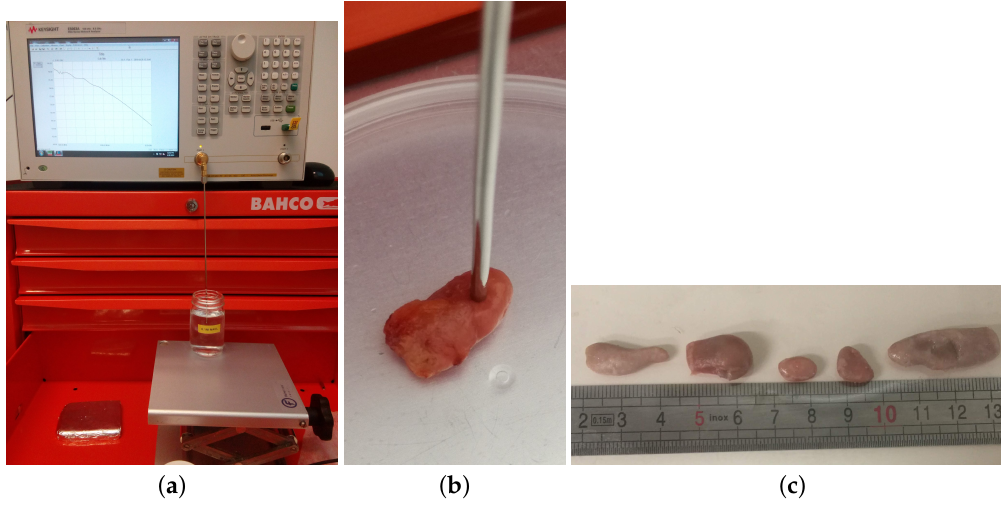
Figure 1. ( a ) Dielectric measurement setup: the open-ended coaxial-probe is connected with a right angle SMA-connector to a vector network analyzer during the measurement of the validation load (0.1 Molar NaCl water solution). ( b ) Detail of a human axillary lymph node measurement. ( c ) Five sheep inguinal lymph nodes that have been